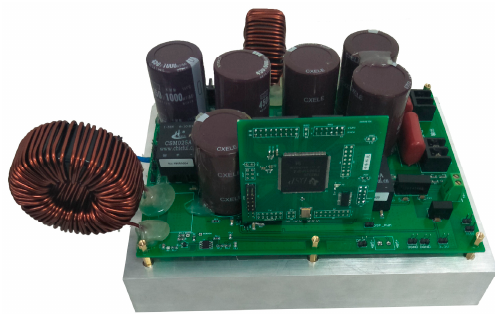
Appl. Sci. 2019 , 9 , x FOR PEER REVIEW